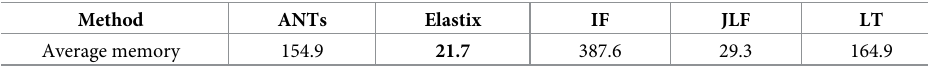
Table 8. Average maximum memory usage for three registration methods and two label fusion